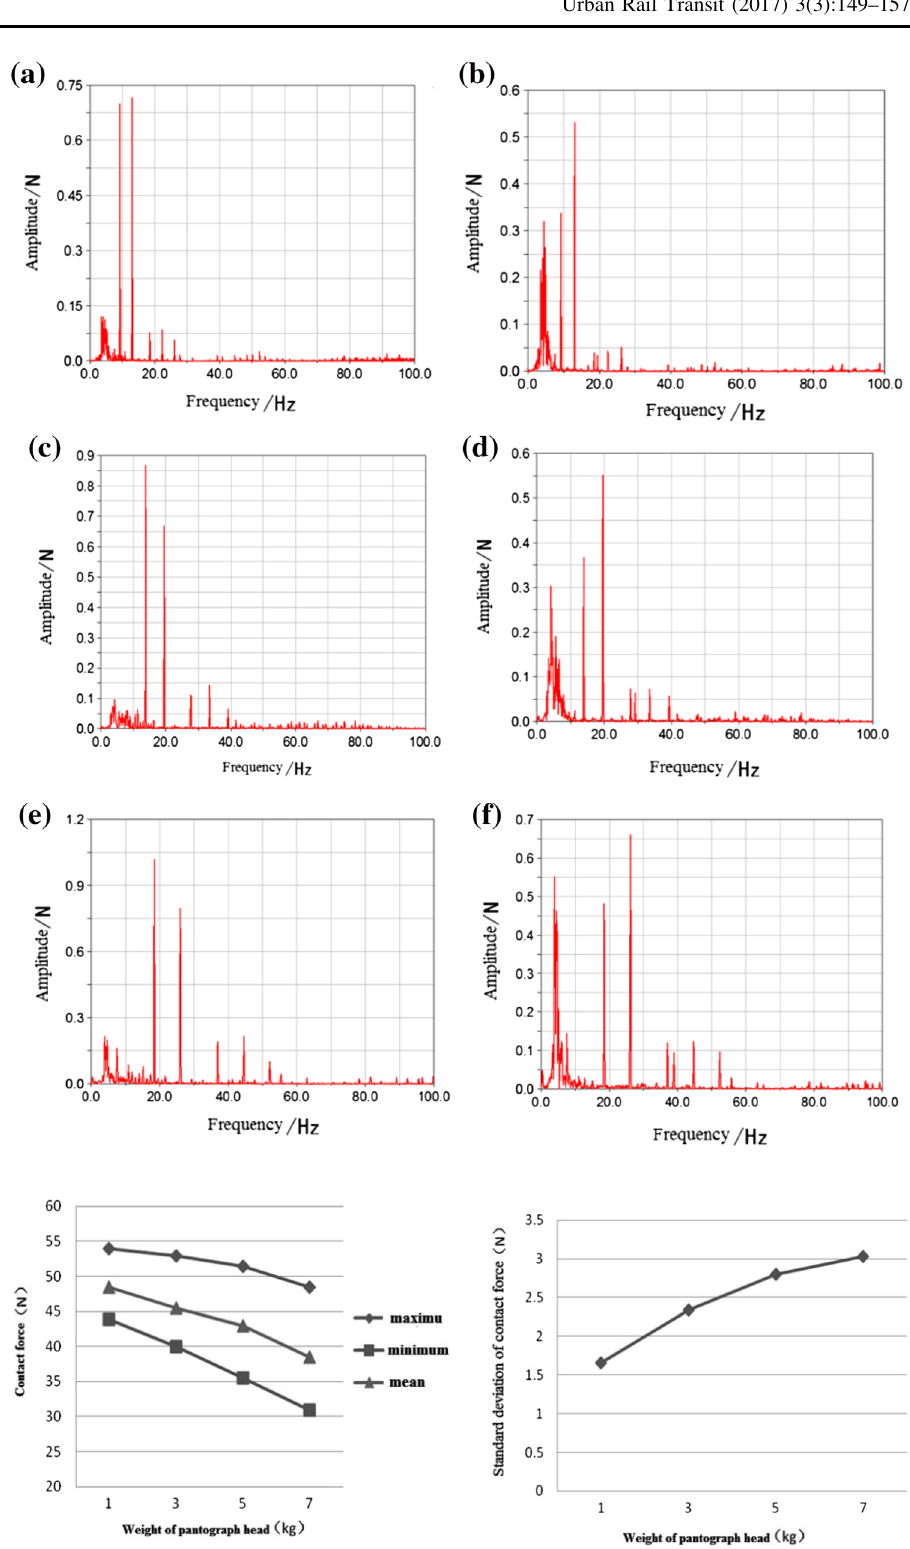
Fig. 8 Frequency spectrum of the contact force in curved track. a Speed 20 km/h left pantograph. b Speed 20 km/h right pantograph. c Speed